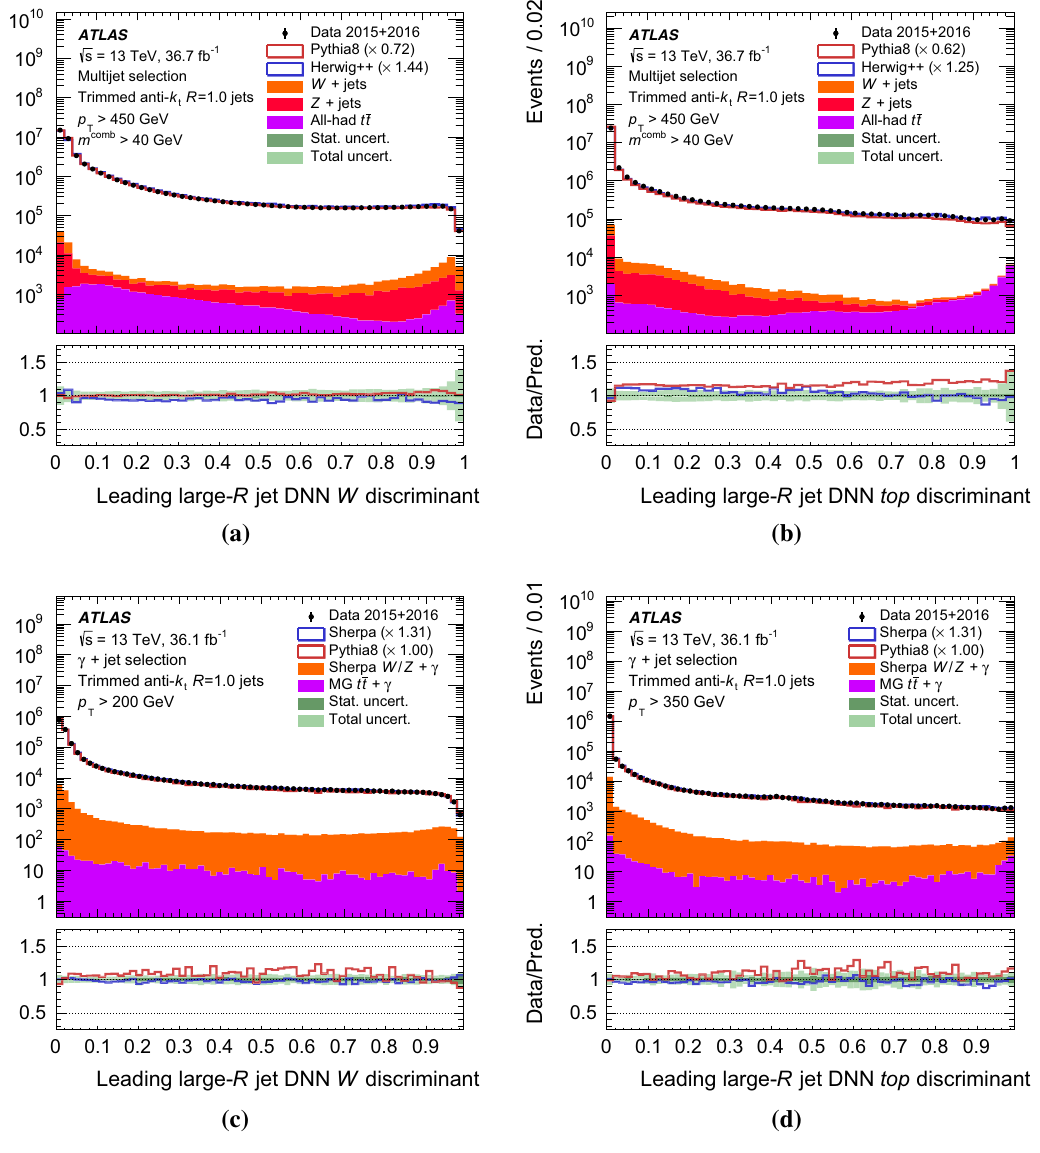
Fig. 27 A comparison of the observed data and MC predictions in the multijet and γ + jet event samples for the anti- k t R = 1.0 trimmed jet spectra of the W -boson ( a , c ) and top-quark ( b , d ) DNN discriminants. The data-driven normalisation correction, described in Sect. 6.2.1, is